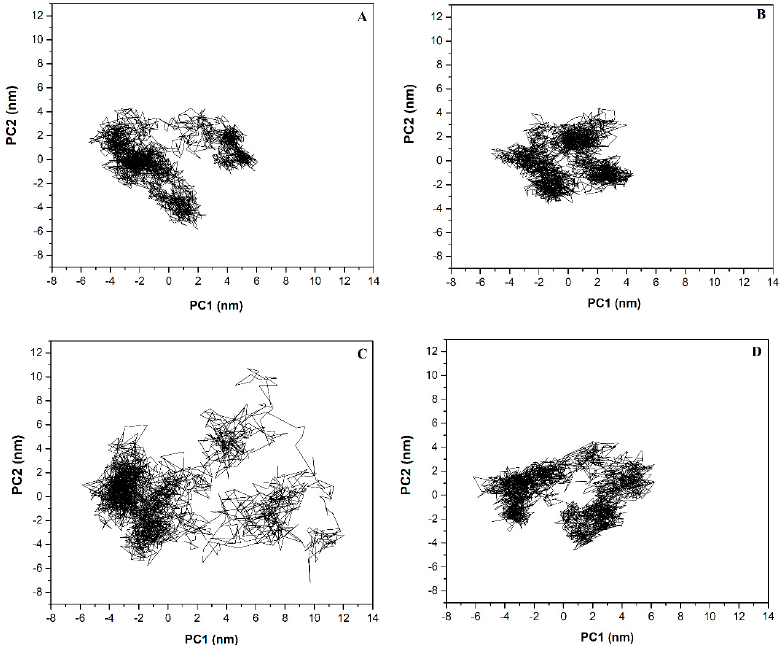
Figure 3. Projection of the free and bound hMOR systems in phase space. Projection of the motion in the phase space along PC2 vs. PC1 for free hMOR ( A ), hMOR-naltrexone ( B ), hMOR-NTXOL ( C ), and hMOR-HMNTXOL ( D ). Molecules 2022 , 27 , x FOR PEER REVIEW